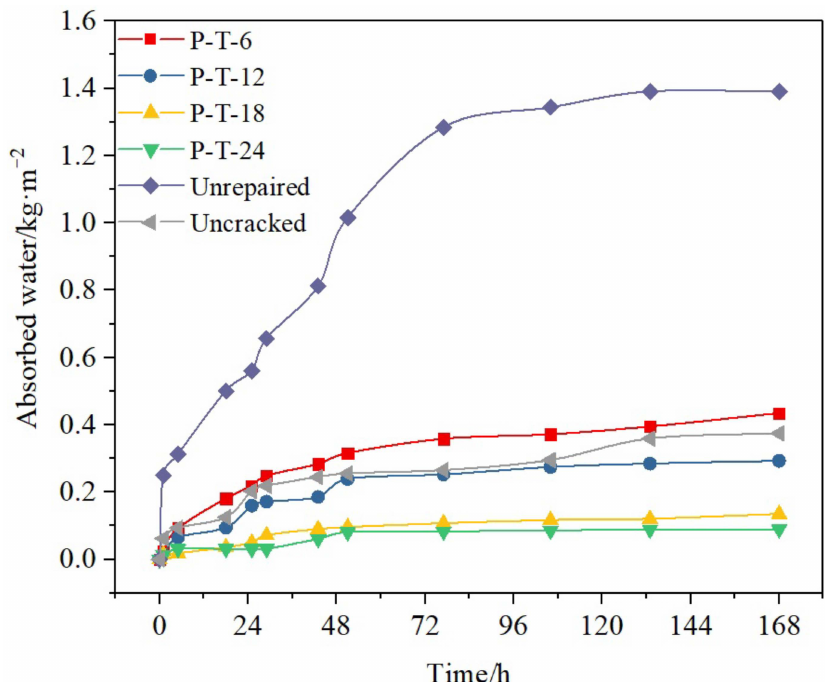
Figure 10. Water absorption of different